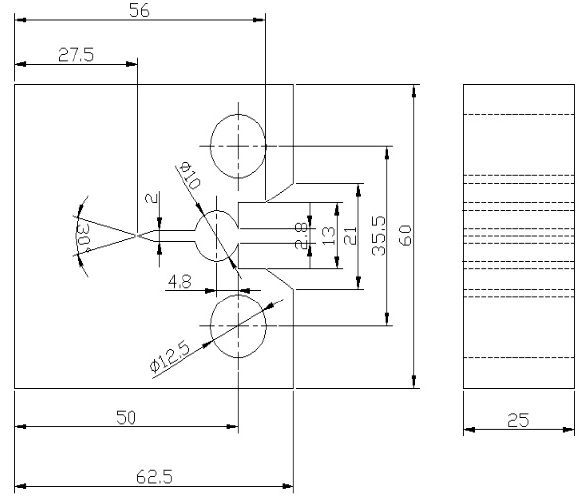
Figure 11. Specimen configuration for fracture toughness test.